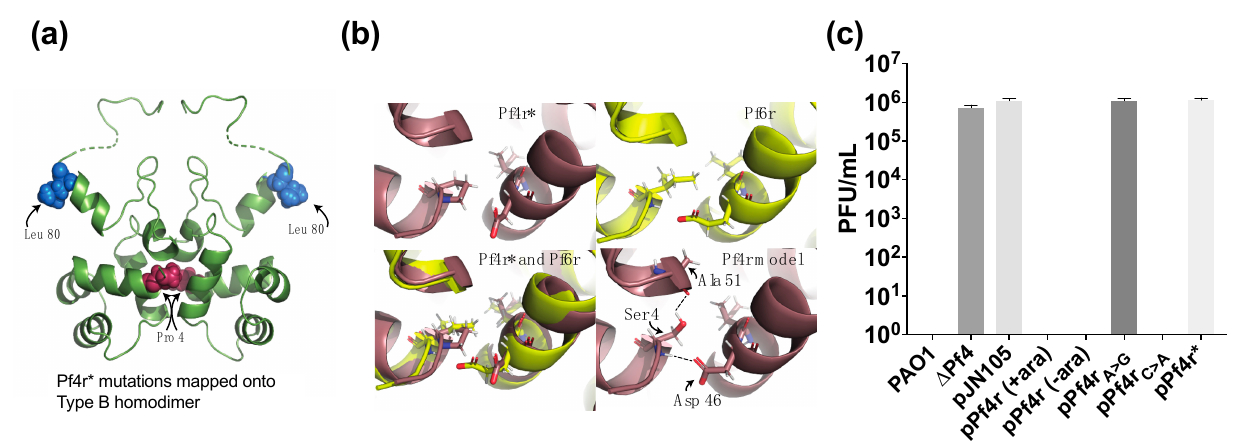
Figure 3. Mutation causing Ser4Pro causes loss of function as immunity factor. ( a ) Space-filling spheres for the two mutations in Pf4r* that stop DNA binding. Leu 80 (blue) is located on the top outside face of the complex and is unlikely to be involved in DNA binding or dimerisation. Proline 4 (pink) is located at the dimerisation interface and may perturb dimerisation. ( b ) Detailed view of the proline residue and the Asp 46 from the opposing dimer chain in close proximity in the Pf4r* crystal complex (top left) and the same region in Pf6r (top right). These sections are overlaid (bottom left). Bottom right shows that the wild-type Pf4r Ser4 residue modelled into the Pro4 position of Pf4r* may be able to make hydrogen bonds with the Asp46 on the opposing chain and form a stabilising interaction. Distances show hydrogen to oxygen distances in Angstrom for the two potential hydrogen bonds as determined in Pymol using the mutagenesis tool and measurement wizard. ( c ) Phage effluent from P. aeruginosa PAO1 was spotted onto different bacterial lawns, and the PFUs were enumerated. N = 3 and n = 3.